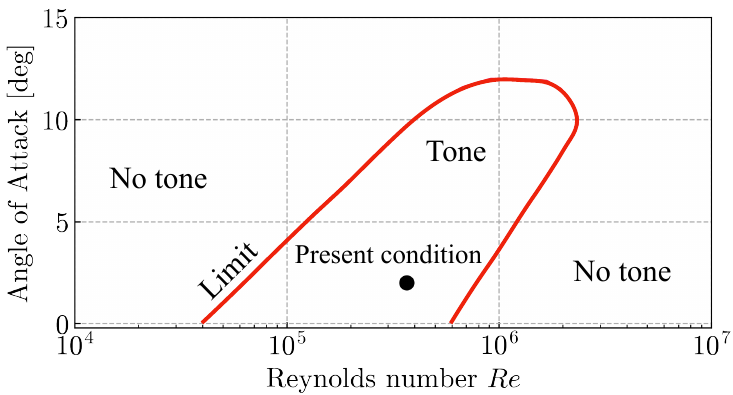
Figure 3. Predicted appearance of LBL instability noise by Lowson et al. [4]. The closed circle indicates the flow configurations employed for the present